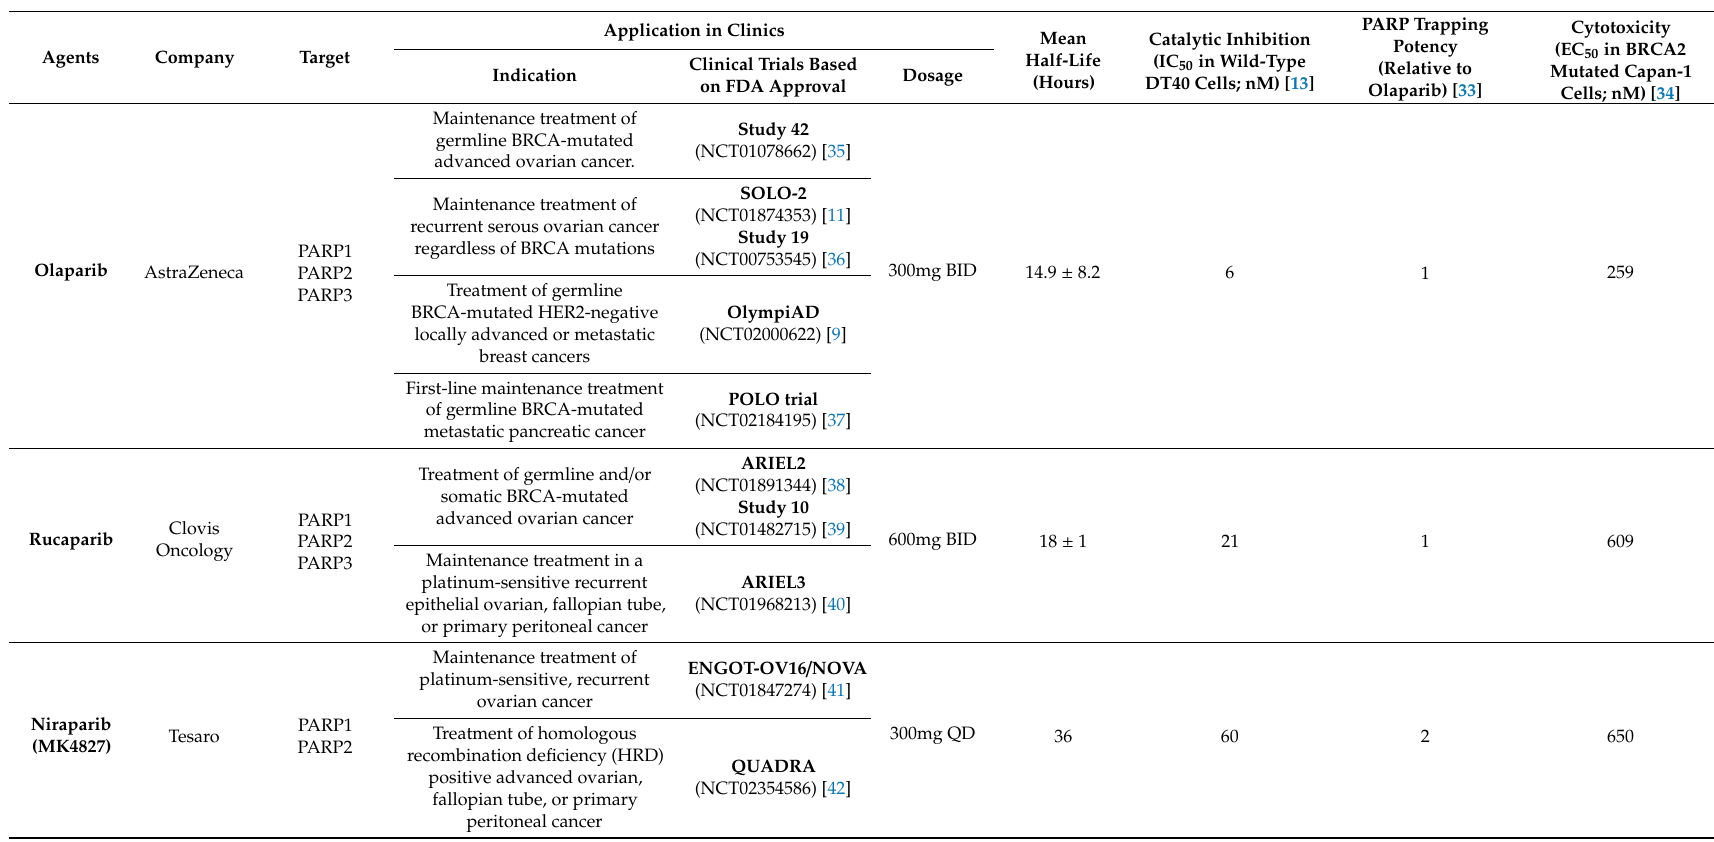
Table 1. Comparison of available PARP inhibitors in the